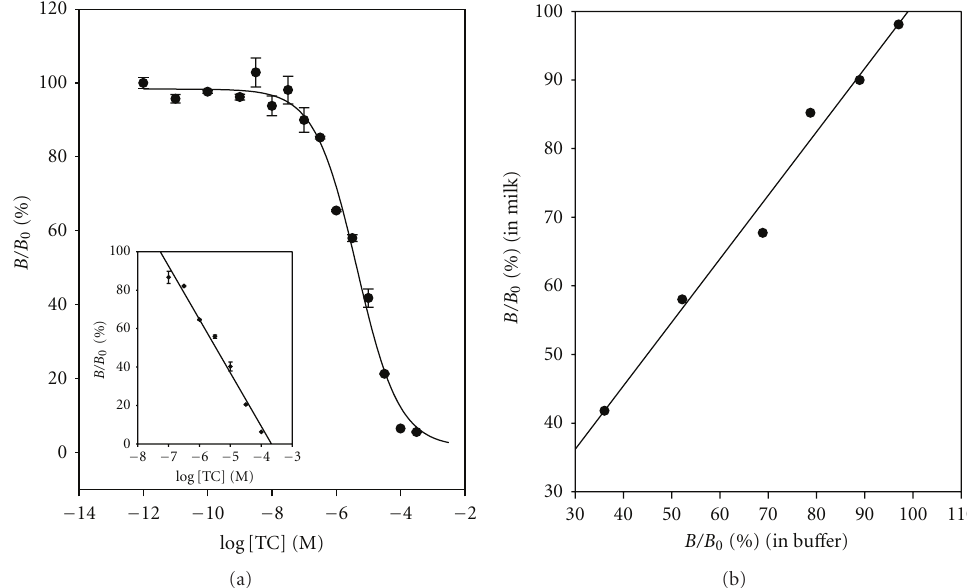
Figure 10: (a) Dose-response curve and calibration curve (inset) for TC in milk. % B/B 0 = − 27.7674 × log [TC] − 101.8244, R 2 = 0 . 9823. (b) Correlation diagram of B/B 0 for TC both in bu ff er and in milk. % B/B 0 (in milk) = 0.9252 × % B/B 0 (in bu ff er) + 8.4232, R 2 = 0 . 9837.